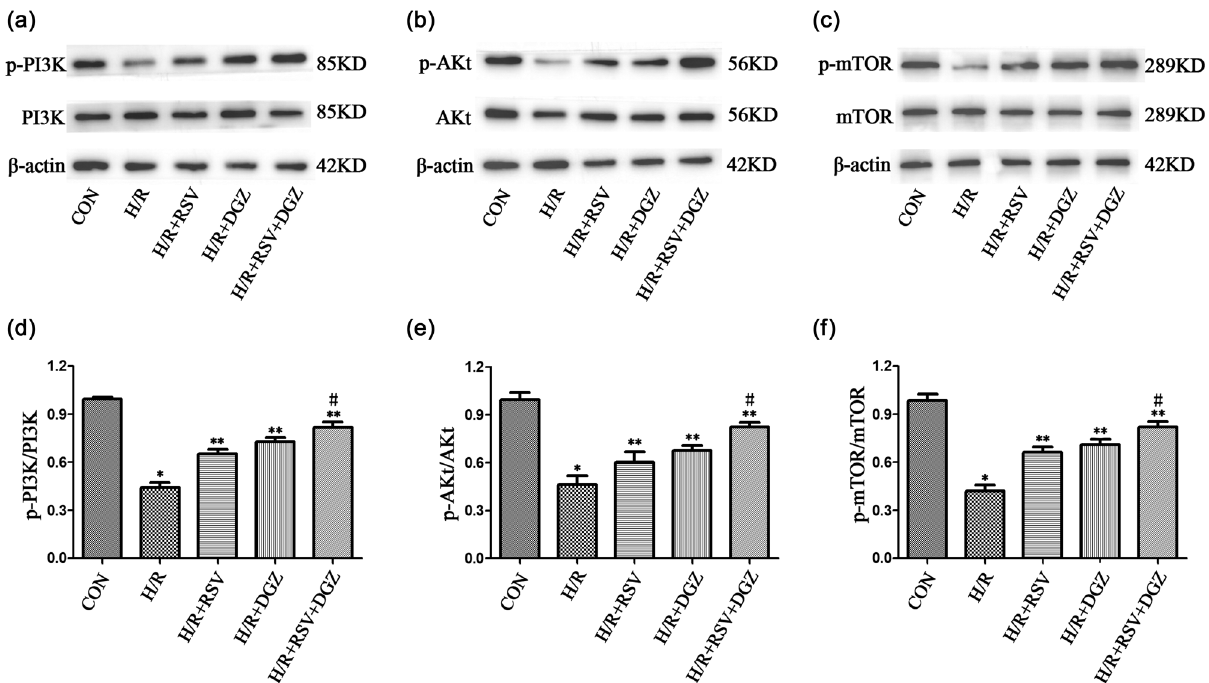
Figure 4: The e ff ects of rosuvastatin and dapagli fl ozin on the PI3K/AKt/mTOR signaling pathway in H/R - induced H9C2 cells ( mean ± SD, n = 3 ) . * p < 0.001 compared with CON; ** p < 0.05 compared with H/R; # p < 0.05 compared with H/R + RSV or H/R + DGZ. CON: control group; H/R: hypoxia/reoxygenation group; H/R + RSV: hypoxia/reoxygenation + rosuvastatingroup; H/R + DGZ: hypoxia/reoxygenation + dapa - gli fl ozin group; H/R + RSV + DGZ: hypoxia/reoxygenation + rosuvastatin + dapagli fl ozin group. p - : phosphorylated; PI3K: phosphatidyli - nositol - 3 - kinase; AKt: protein kinase B; mTOR: mechanistic target of